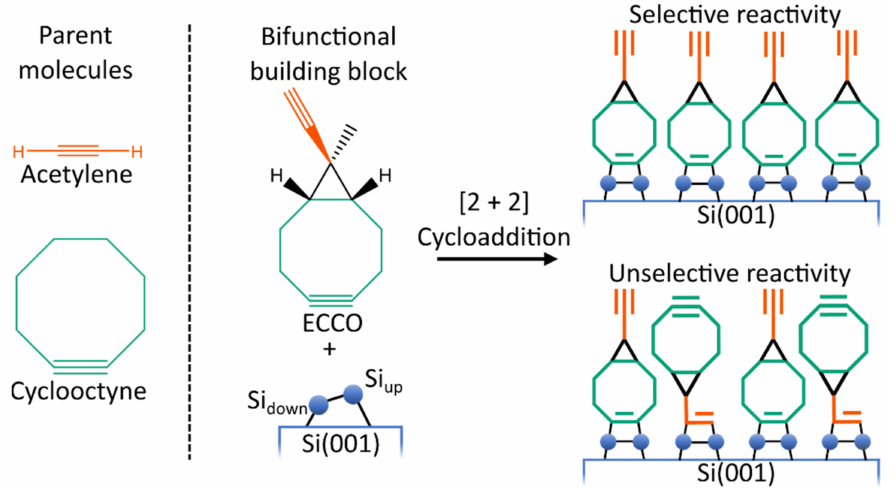
Figure 1. Lewis structure of the parent molecule acetylene and cyclooctyne and of 9-Ethinyl-9- Methylbicyclo[6.1.0]non-4-in (ECCO). Schematic illustration of the competitive bonding of the ethinyl (orange) and cyclooctyne (green) group, resulting in the desired selective or unwanted unselective adsorption